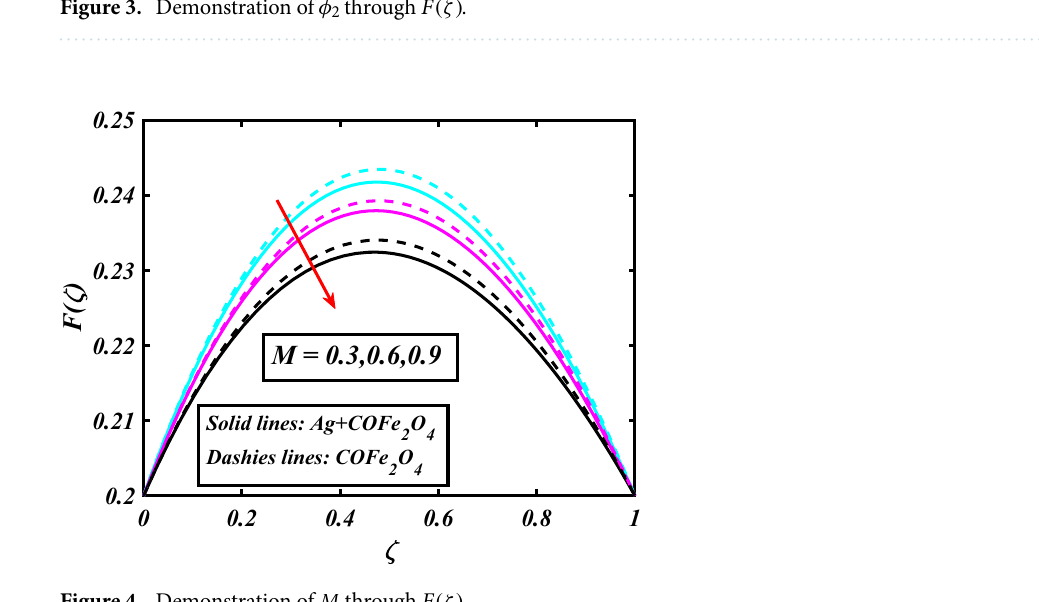
Figure 4. Demonstration of M through F (ζ) .